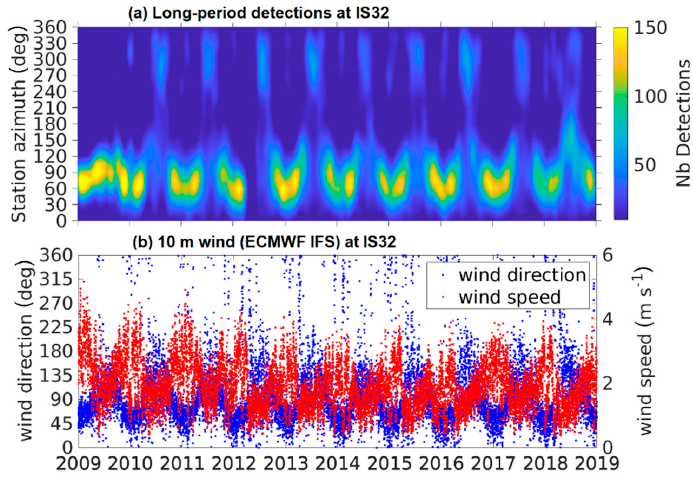
Figure 7. Similar to Figure 6, but for IS32 in Kenya. The database for ( a ) is 42,456 event detections within 10 years. The average back-azimuth standard deviation of the detected events is 1 ◦ . The PMCC correlation coe ffi cients average to 0.79 ± 0.13. In ( b ), a sliding average with a window length of 1 d was applied to the ECMWF